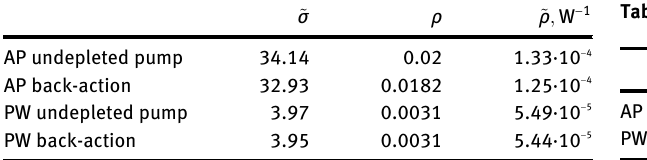
Table  : Scattering and second-harmonic conversion ef fi ciencies.